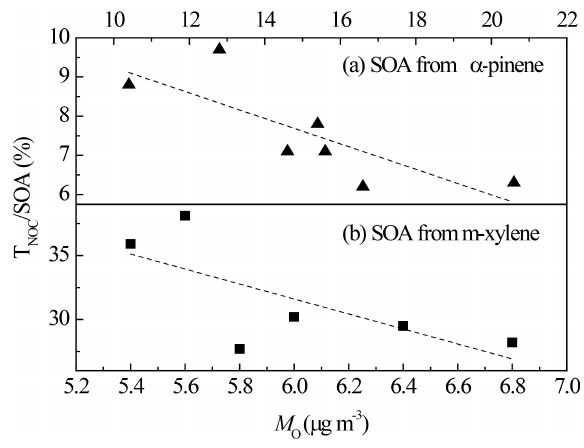
Figure 7. Relative contribution of NOC to the total SOA ( T NOC / SOA) as a function of organic mass loading for α - pinene and m -xylene experiments at constant particle acidity (H 2 SO 4 / Na 2 SO 4 :